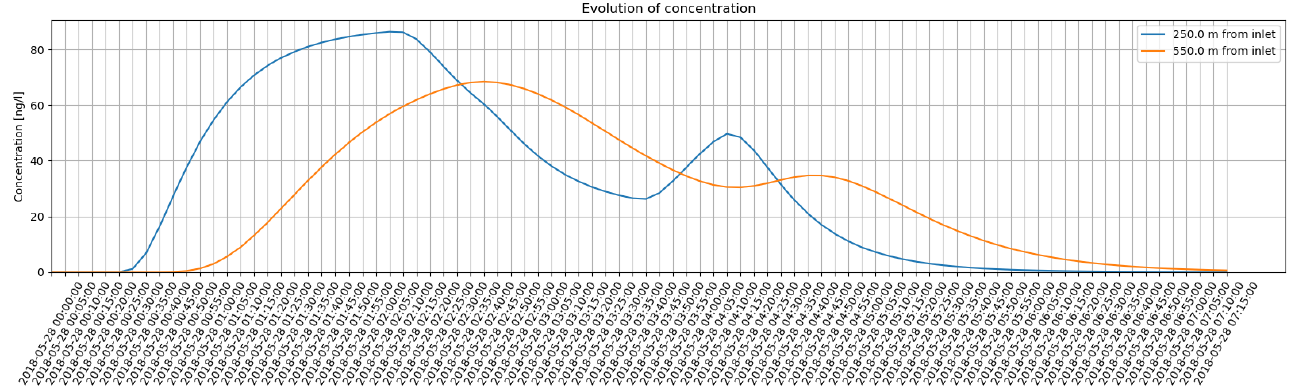
Figure 5. Example graph: solution at a selected points as function of time. Two points selected by using the GIS selection tools.